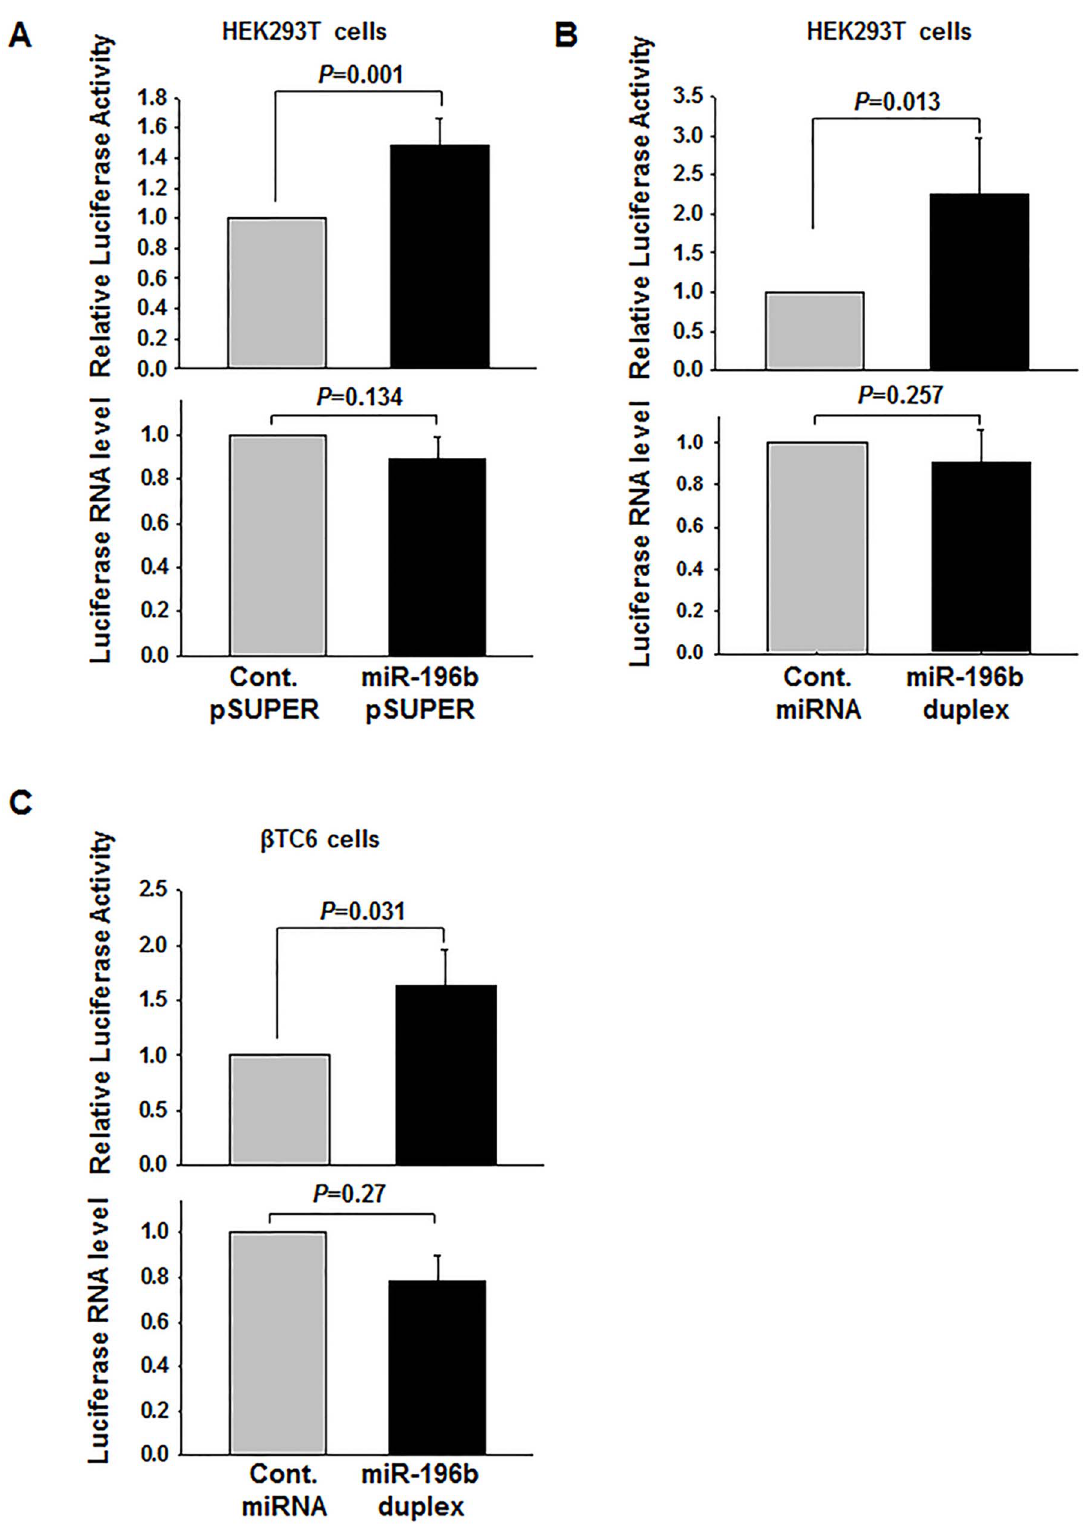
Figure 1. miR-196b activates insulin2-reporter expression. (A) HEK293T cells were co-transfected with the insulin2 reporter and with miR- 196b pSUPER/cont miR pSUPER. Forty-eight hr later, firefly and Renilla luciferase activities were measured. (B, C) The miR-196b duplex/Control siRNA was transfected along with insulin2 reporter construct and Renilla luciferase as internal control in HEK293T (B) or b TC6 (C). The fold change in translation is shown for the insulin2 reporter, with expression levels of control miRNA-transfected cells set to 1. The relative RNA levels as assessed by RT-qPCR are indicated in the bottom panel. The graphs represent the means 6 SD of 3–9 independent experiments; P values (Student’s t-test) are indicated.